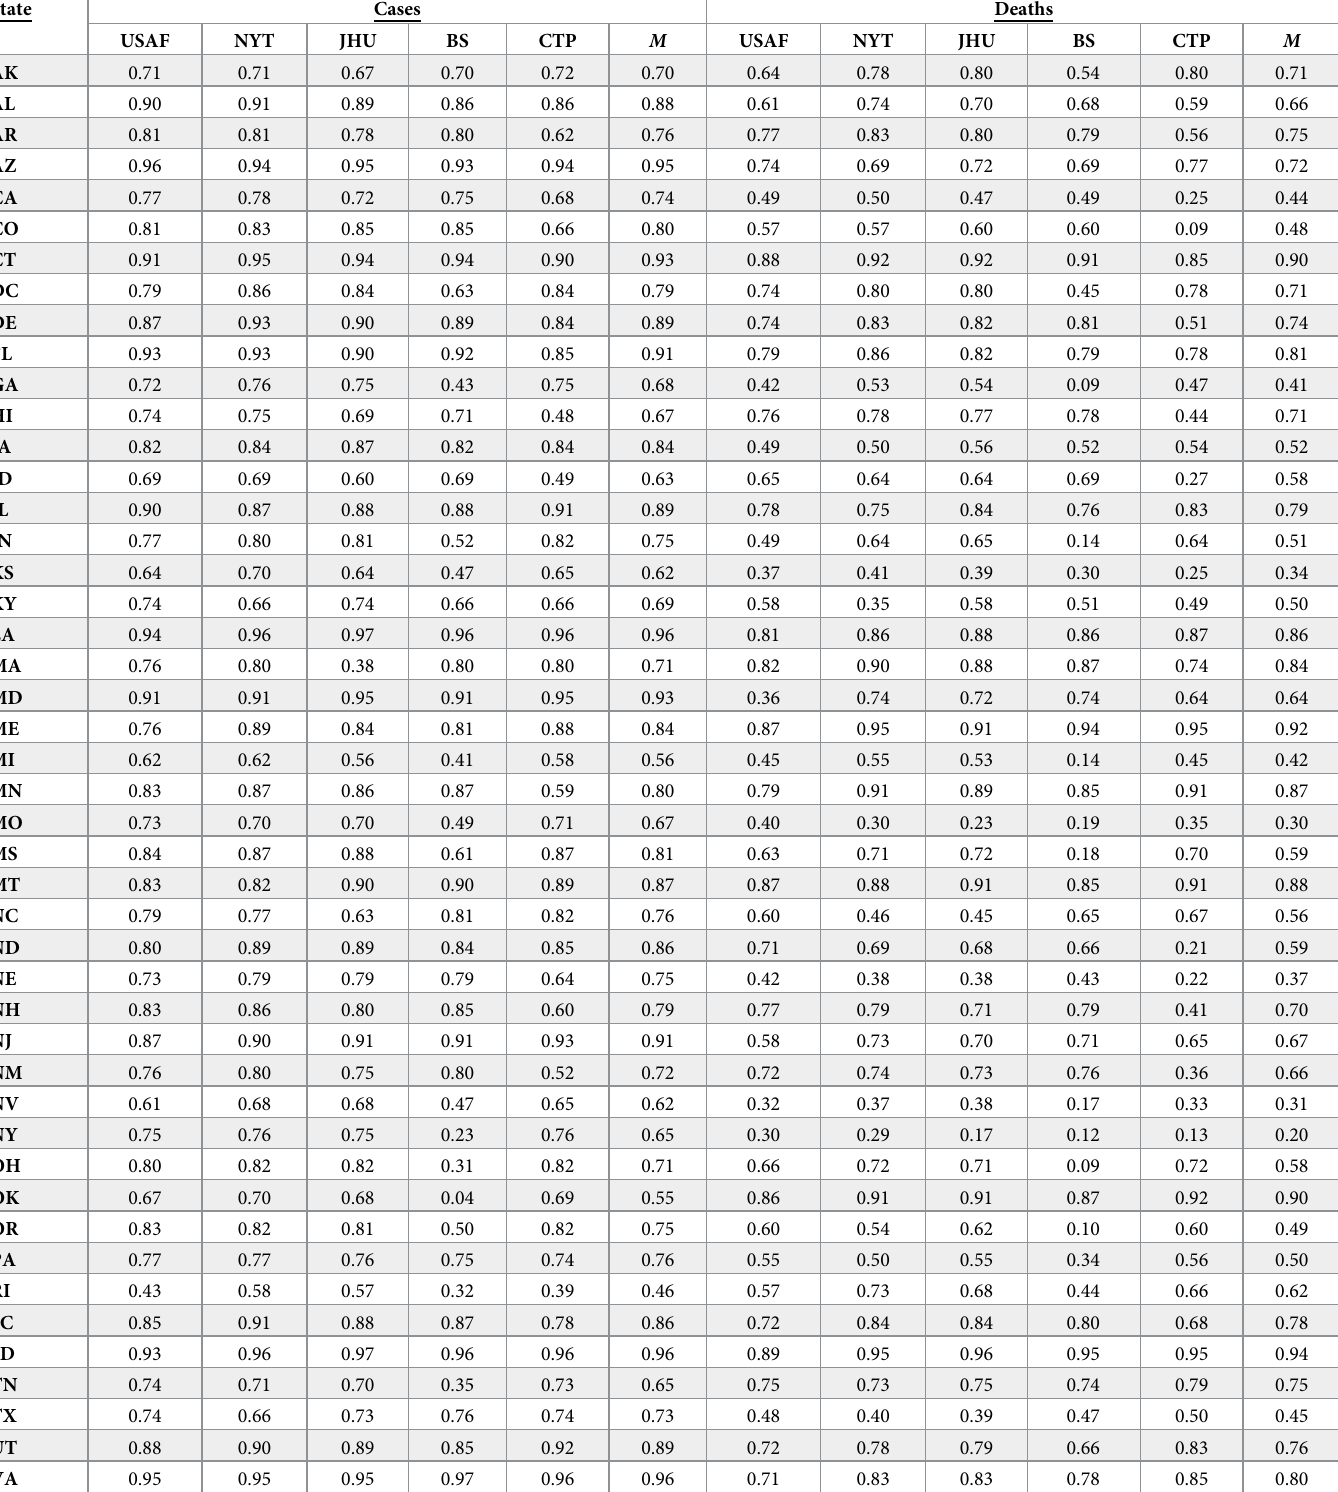
Table 4. Average kappa (Fig 3) for each aggregator by state.